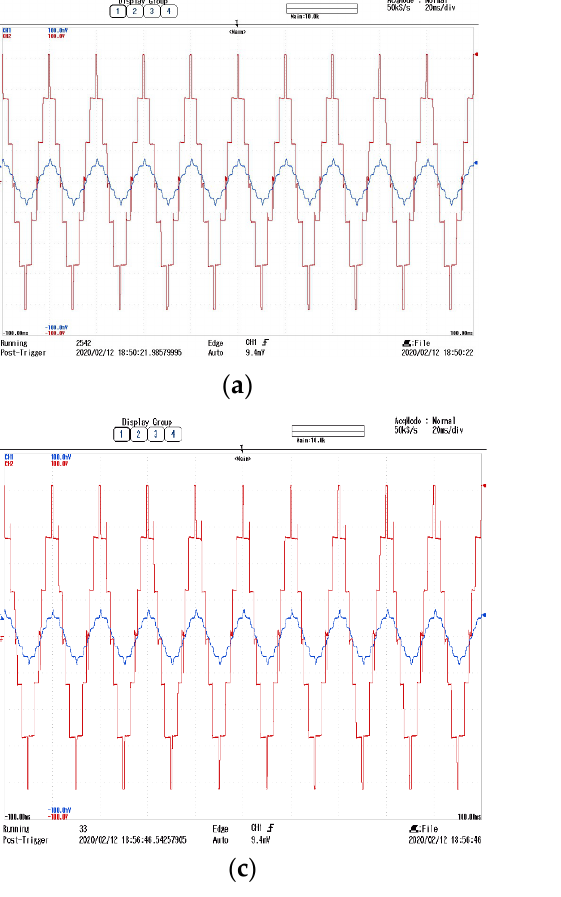
Figure 16. Hardware result of the Quasi-linear MLI for 3rd order harmonic elimination using: ( a ) the conventional technique; ( b ) THD analysis of the conventional technique; ( c ) the proposed technique; and ( d ) THD analysis of the proposed technique.